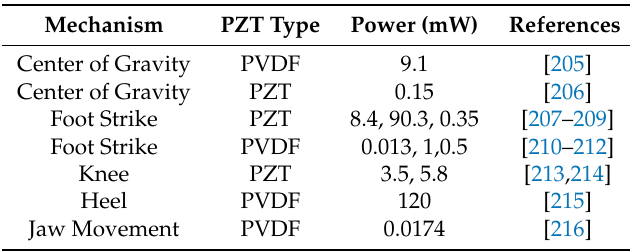
Table 4. Biomechanic-based